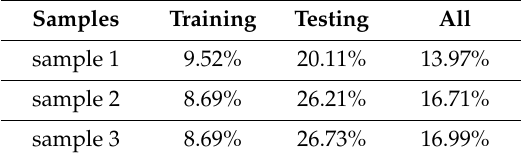
Table 1. Root mean square error (RMSE) between measured and estimated FMC.